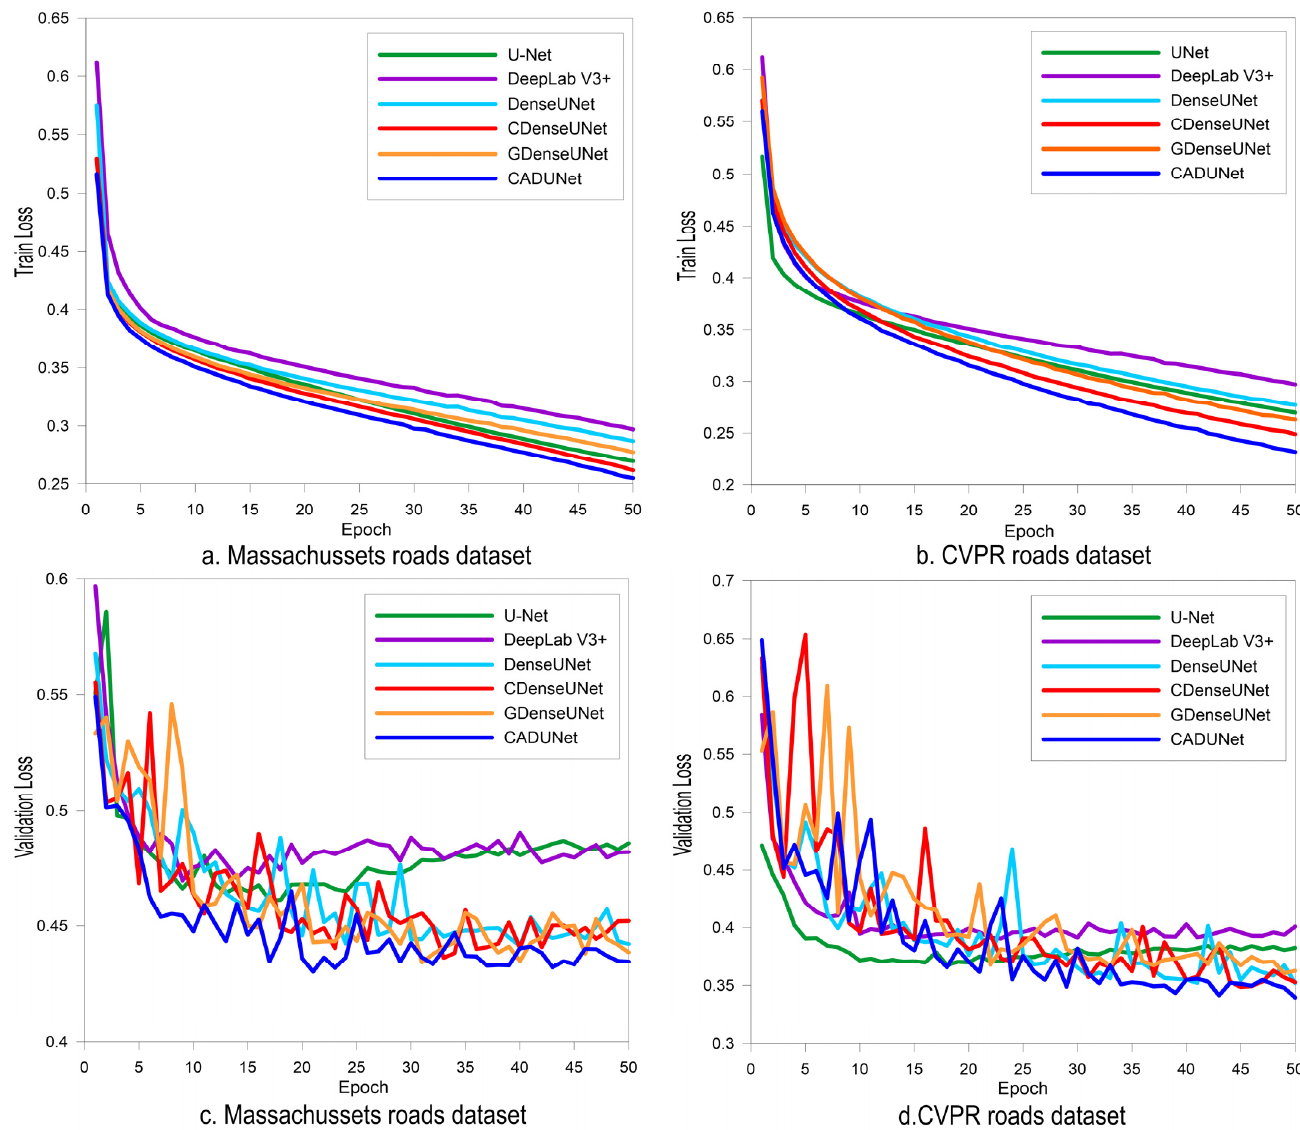
Figure 10. Training and validating curves.